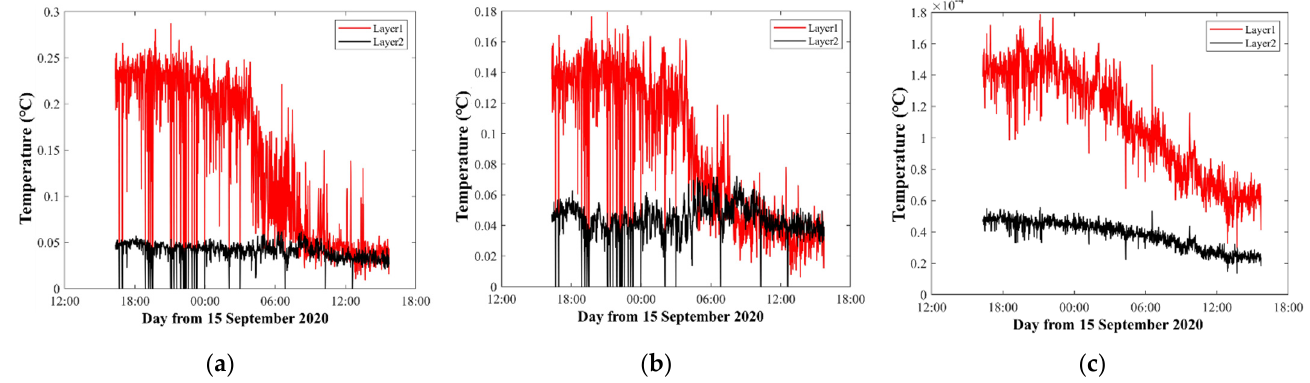
Figure 11. Temperature inversion errors. The red and black curves indicate the errors of the first layer and the second layer, respectively. ( a – c ) Correspond to the results of Figure 9a–c, respectively.